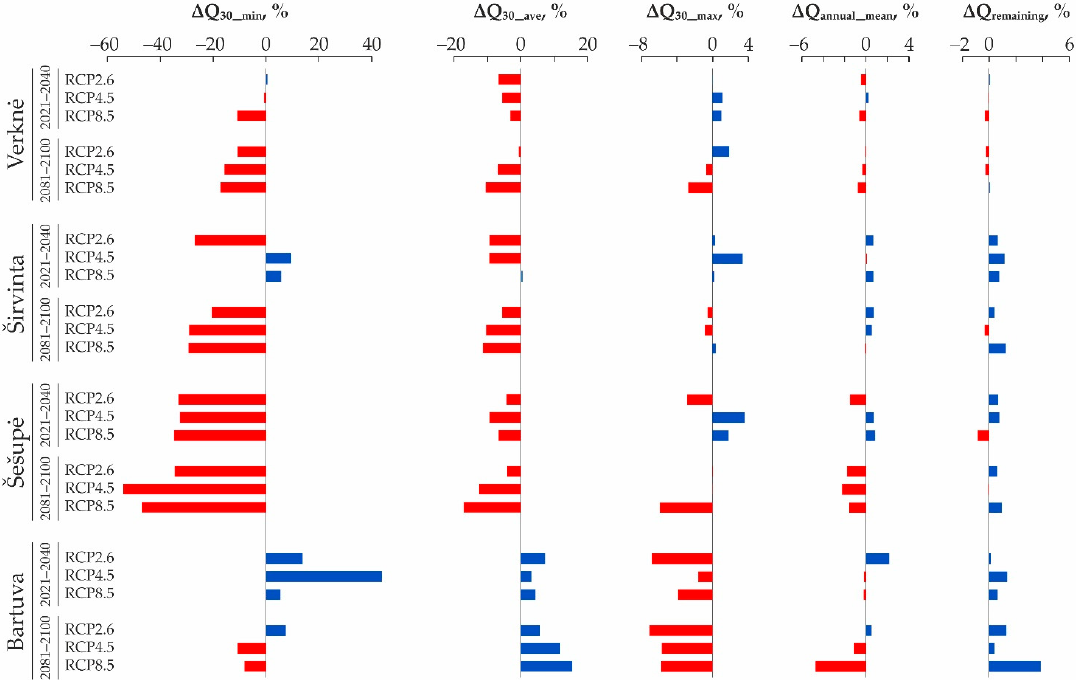
Figure 4. Deviations (%) of values of target discharge in the Verkn ė , Širvinta, Šešup ė and Bartuva rivers according to different RCP scenarios for the periods of 2021–2040 and 2081–2100 compared to the reference period of 1986–2005.